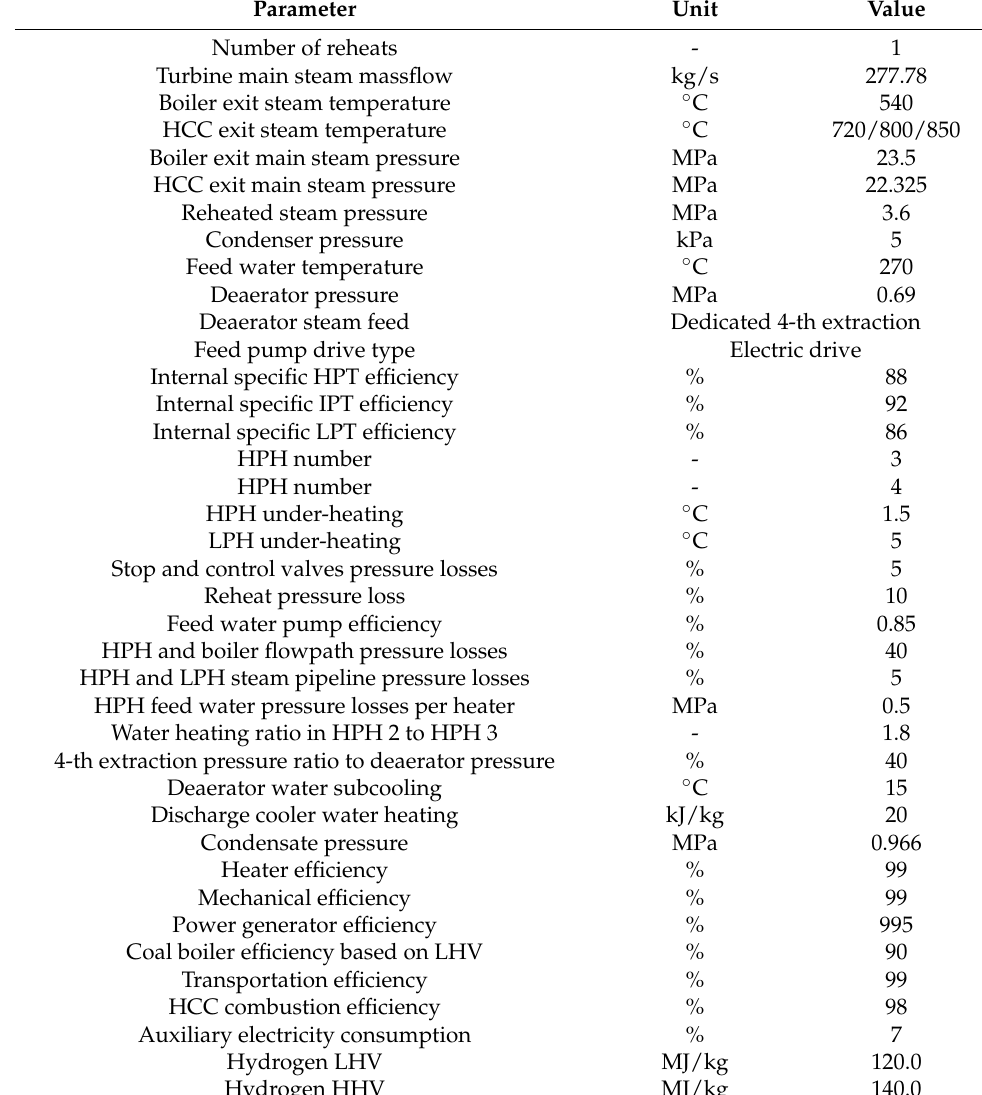
Table 5. Input data for the power unit